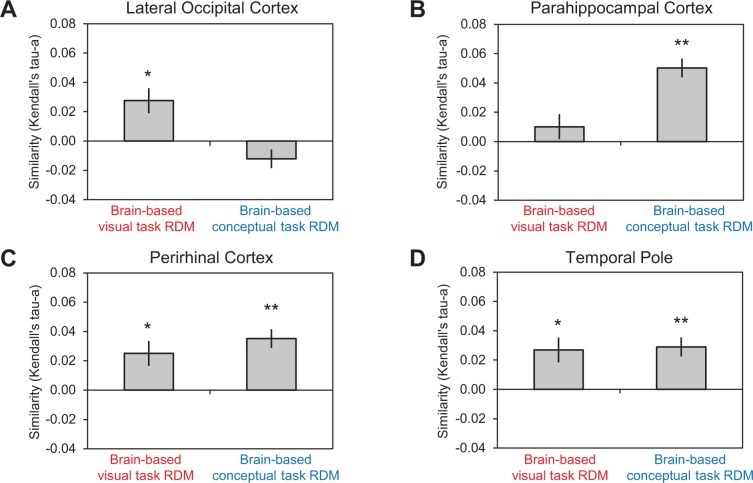
Comparison of word2vec RDM with brain-based RDMs.Similarities between the word2vec RDM and brain-based RDMs are plotted for (A) LOC, (B) parahippocampal cortex, (C) PRC, and (D) the temporal pole. Similarity was quantified as the ranked correlation coefficient (Kendall’s tau-a) between behavior-based RDMs and the brain-based RDMs. Error bars indicate standard error of the mean. **p<0.01, *p<0.05 (Bonferroni corrected). Participant-specific Kendall’s tau-a co-efficients are contained in Figure 6—source data 1 - Comparison of similarity models and brain-based RDMs.